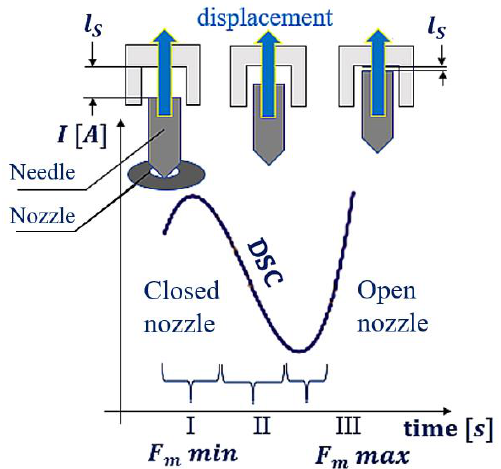
Figure 6. Comparison of the current waveforms of the RL circuit, performing the work and non- performing.